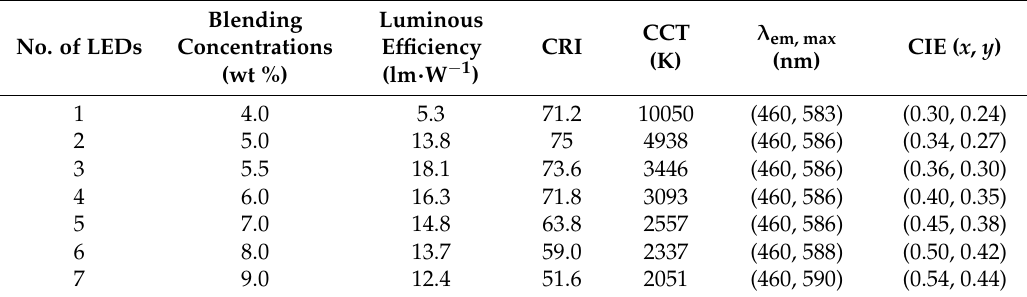
Figure 5. Emission spectra of the blue GaN-based light-emitting diodes (LEDs) using the polymer ( x wt %, x = 4.0, 5.0, 6.0, 7.0, 8.0 and 9.0) as phosphors blended in silicone at different blending concentrations. Table 1. The performance data of GaN-based light-emitting diodes (LEDs) using the polymer as down-conversion luminescent materials blended in silicone at different blending concentrations ( x wt %, x = 4.0, 5.0, 5.5, 6.0, 7.0, 8.0, 9.0). CRI—color rendering index; CCT—correlated color temperature;